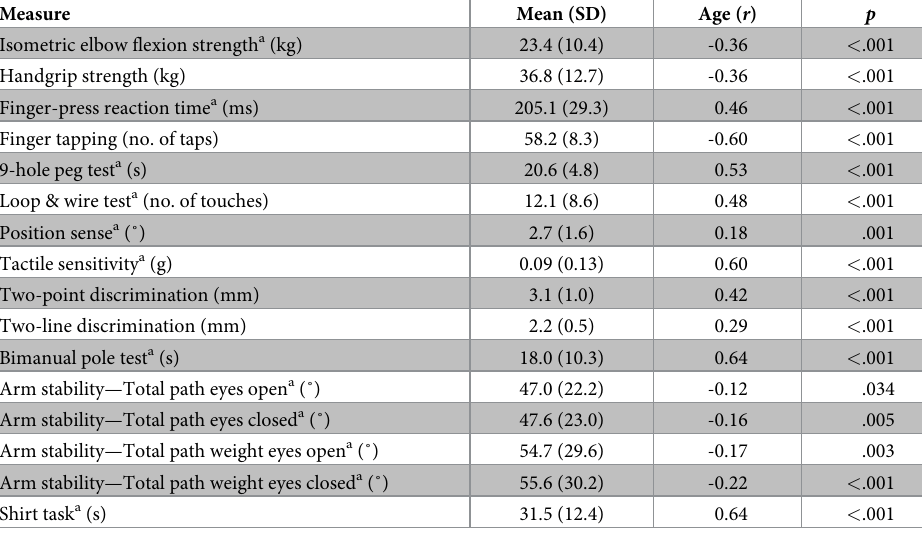
a log 10 transformed prior to statistical testing due to skewed data Note: Negative r values for isometric elbow flexion strength, handgrip strength and finger tapping indicate worsening performance with increasing age. Positive r values for all other tests indicate worsening performance with increasing